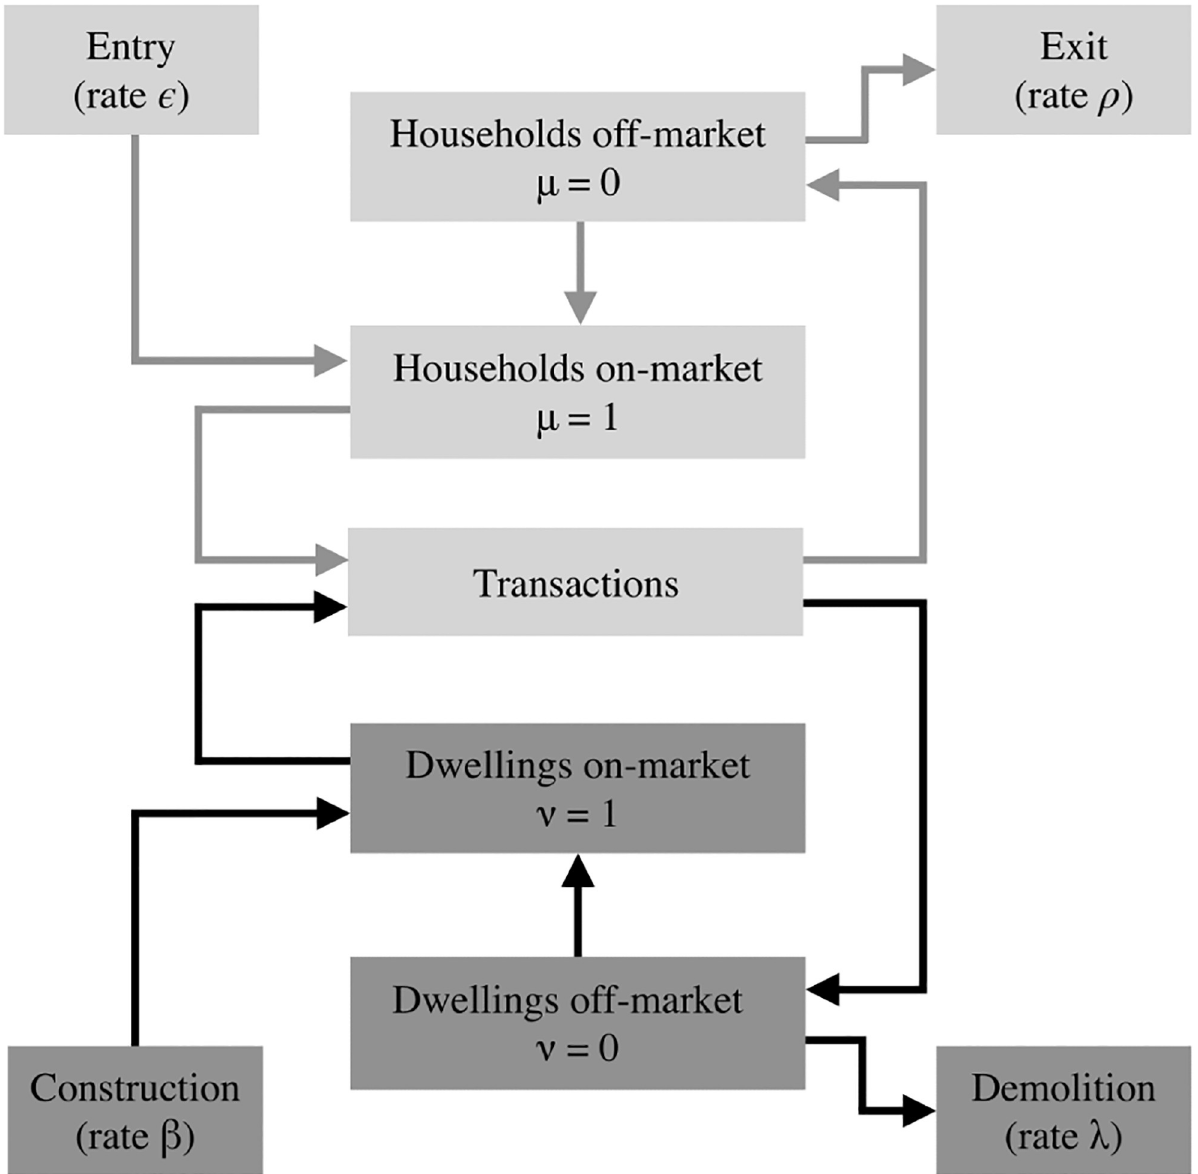
Fig 6. Schematic of how various changes in housing supply and population feed into transactions.